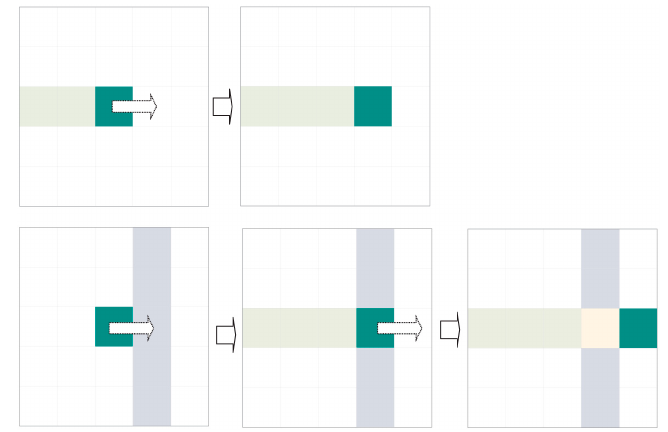
Figure 13. ( Top ) Forward movement straight in the direction of motion is favoured. The agent remembers the visited positions (the track); ( Bottom ) The agent ignores positions visited by agents travelling in the opposite direction.